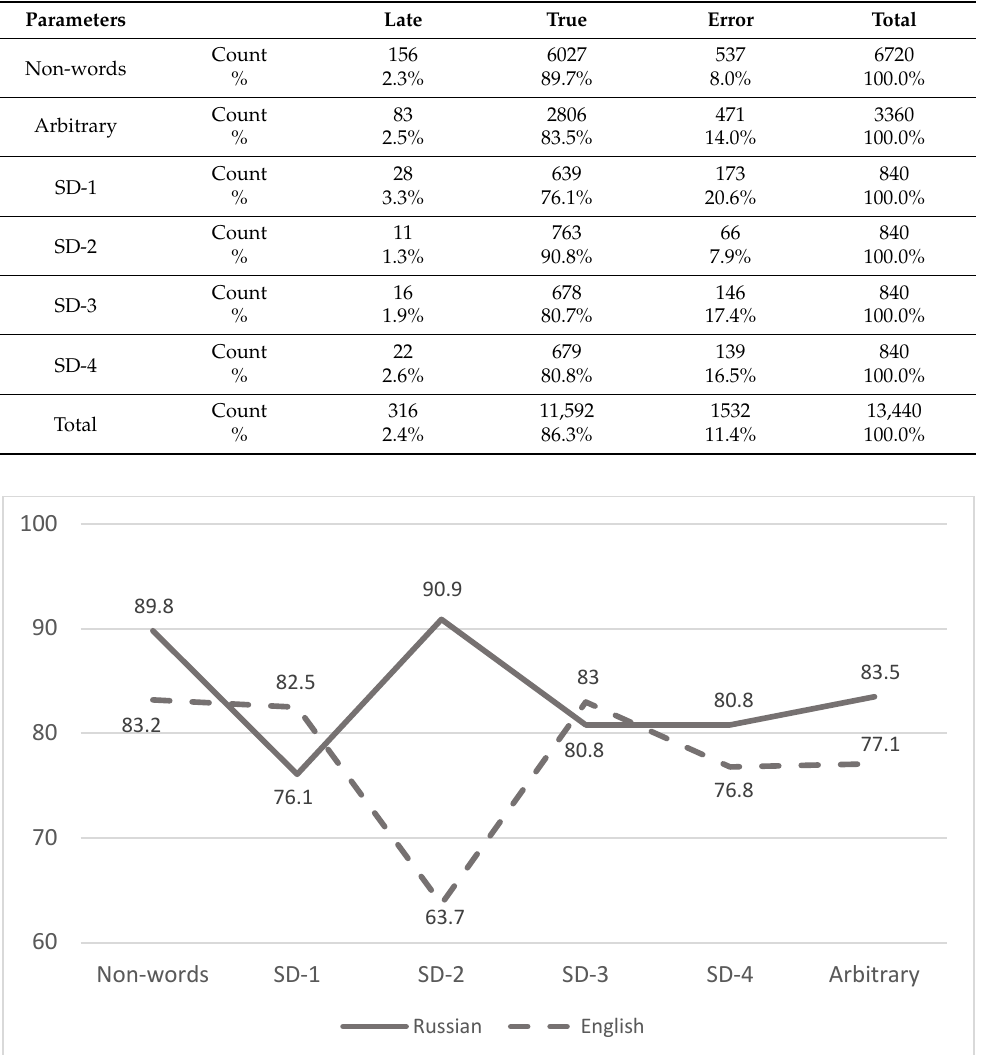
Table 4. Contingency table Parameter*Accuracy for the Russian-language Sample.